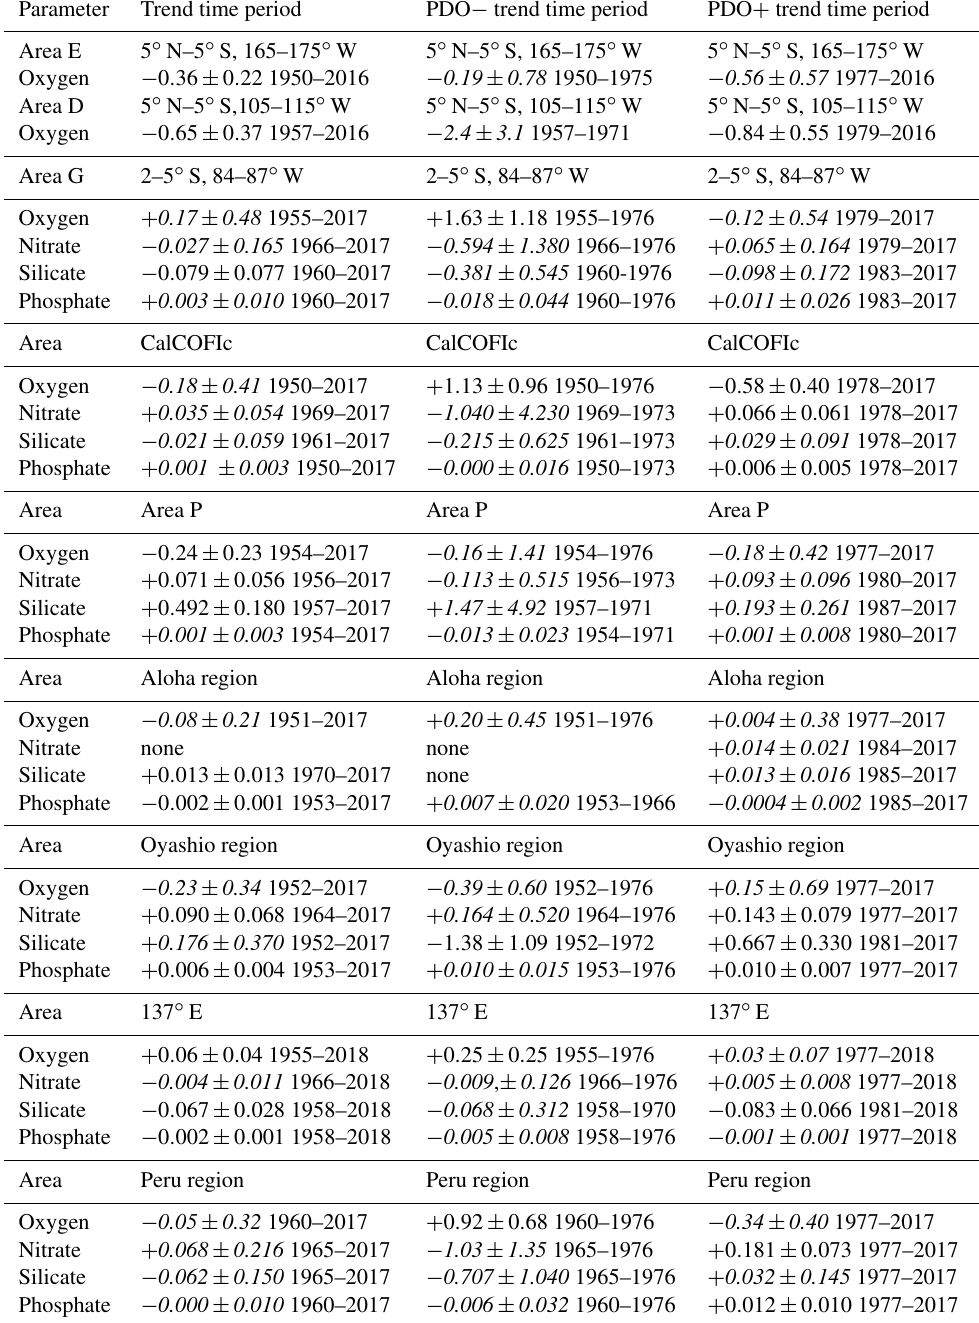
Table 1. Linear trends of solutes in micromoles per kilogram per year with 95% confidence intervals ( p values) where data are available for the entire period since 1950, for negative (1950–1976; PDO-) and positive (after 1976; PDO + ) PDO periods in the 50 to 300m depth layer for selected ocean areas shown in Figs. 3, 4, 5, 7, S3, S4, S5 and S6. Trends whose 95% confidence interval includes zero are shown in italics. Areas are named CalCOFIc (34–35 ◦ N, 121–122 ◦ W), area P (48–52 ◦ N, 143–147 ◦ W), Aloha region (22–25 ◦ N, 156–159 ◦